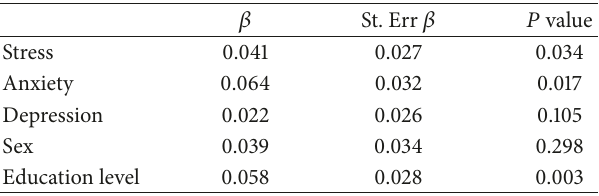
Table 5: Results of linear regression of effects of stress, anxiety, depression, sex, and education level on sleep quality.